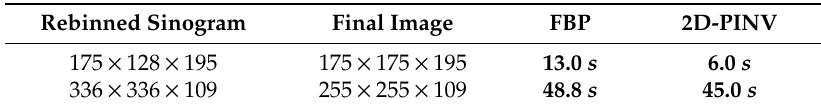
Figure 12. YZ plane reconstructed with PINV z + 2D-PINV of a 13 g mouse injected with 120 μ Ci of 18 FDG.